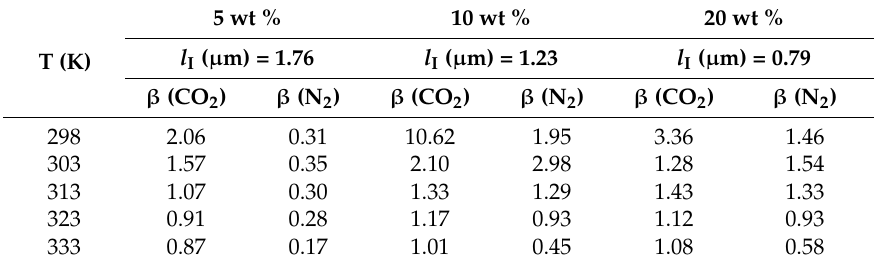
Parameters estimated by the reduced mobility modified Maxwell model for the RHO/PTMSP